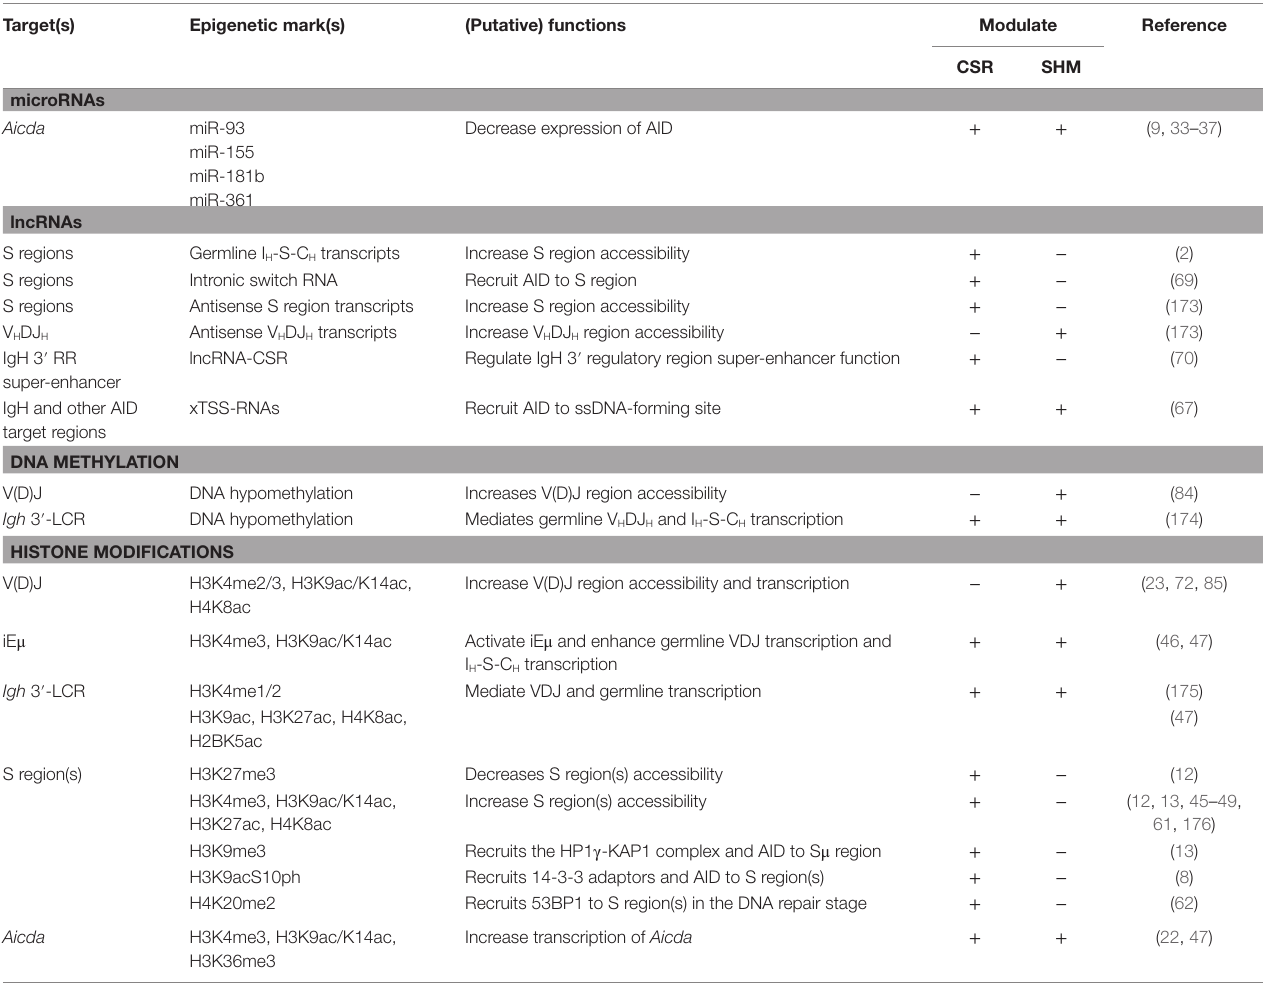
TABLe 1 | epigenetic marks/factors, and their functions in CSR and